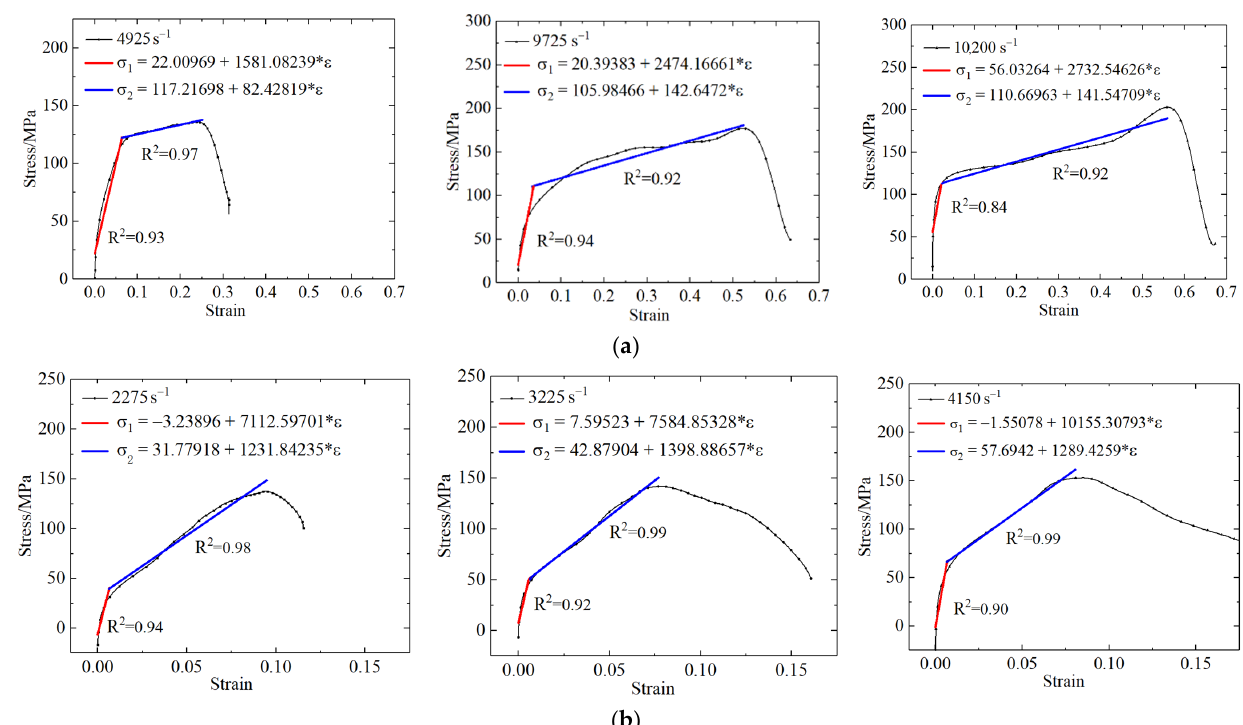
Figure 6. Schematic diagram of linear fitting of stress-strain curve of ( a ) PLA; ( b ) PLA-Cu.